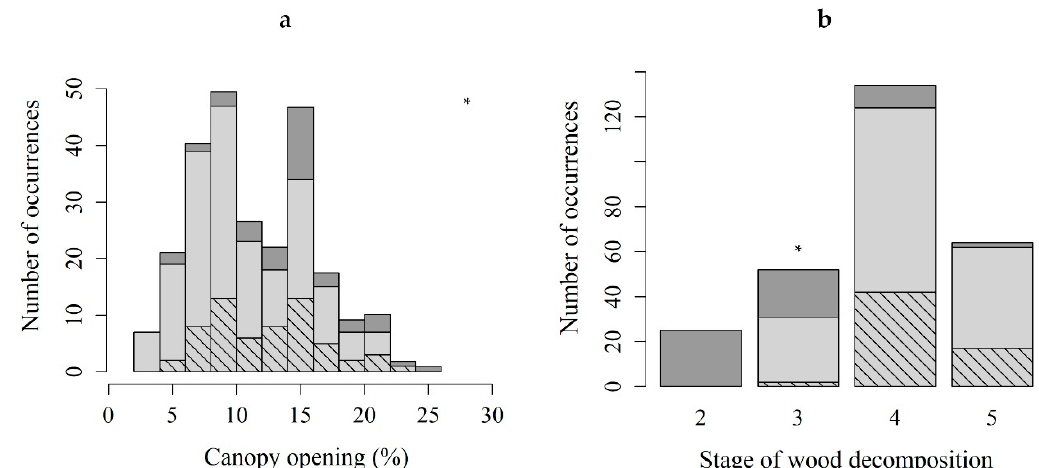
Figure 3. The number of occurrences of the protonemal stage of Buxbaumia viridis (light gray) and the sporophyte stage (hatched) classified by canopy opening ( a ) and stage of wood decomposition ( b ). Dark gray: total stands surveyed. The two variables were significantly different between microhabitats with sporophytes, and those with protonemal stage only (Kruskal–Wallis chi-squared = 31.254, df = 1, p -value < 0.05 for canopy opening, and χ 2 test, p < 0.05 and absolute residual value > 2 for stage of wood decomposition); * p ≤ 0.05.